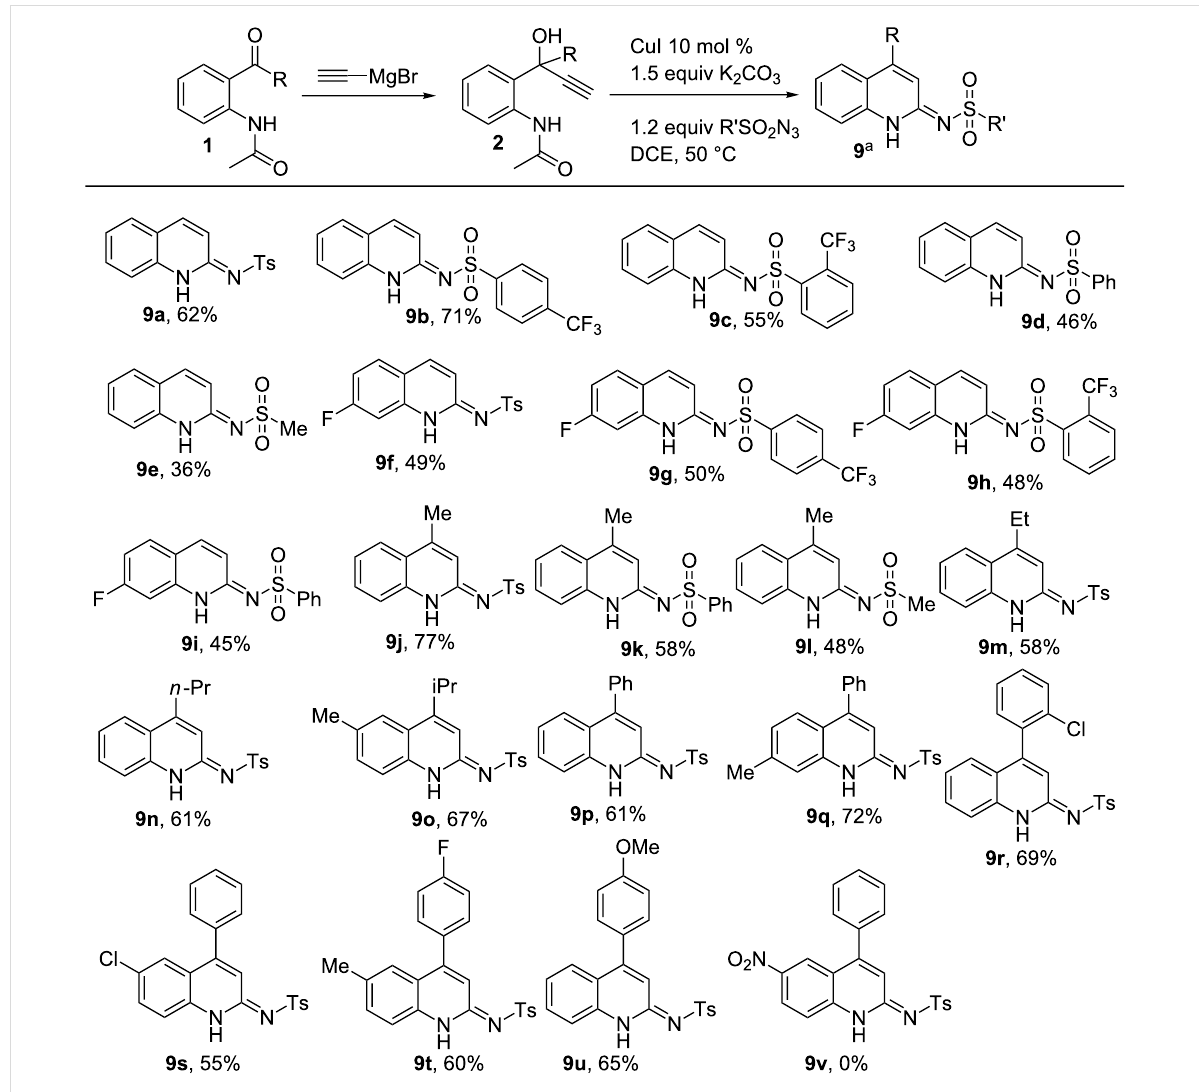
Scheme 3: Synthesis of 1,2-dihydro-2-tosyliminoquinolines. Reaction conditions: Sulfonyl azide (1.2 mmol), 2 (1.0 mmol), base (1.5 mmol), CuI (0.1 mmol), DCE (5 mL, 0.2 M solution), 50 °C, open air. a Isolated